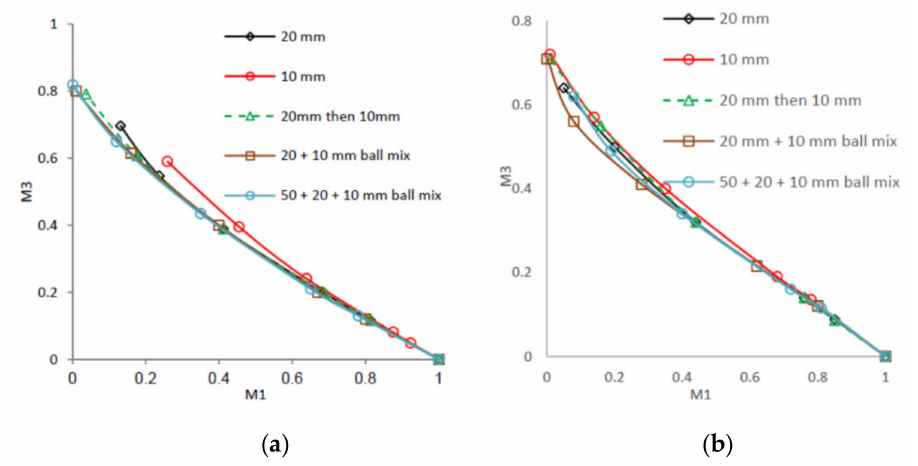
Figure 11. Mass fraction m 3 vs. m 1 for various ball sizes ( a ) feed size = − 1700 + 850 µ m ( b ) feed size − 1180 + 850 µ m